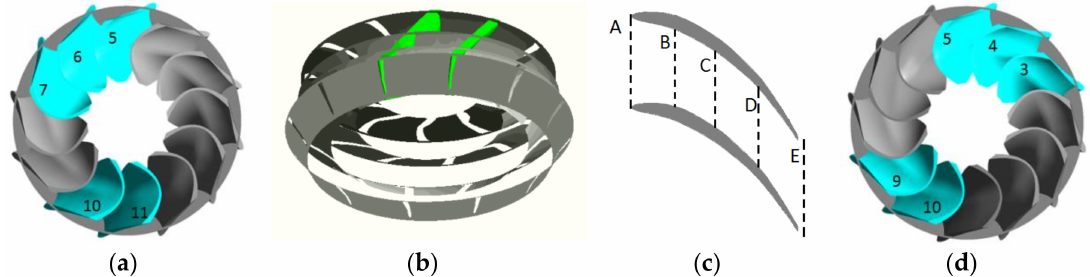
Figure 6. Selected passages and sections on the turbine blades ( a ) in equal admission; ( b ) in three-dimensional (3D) view; ( c ) in two-dimensional (2D) view; ( d ) in partial